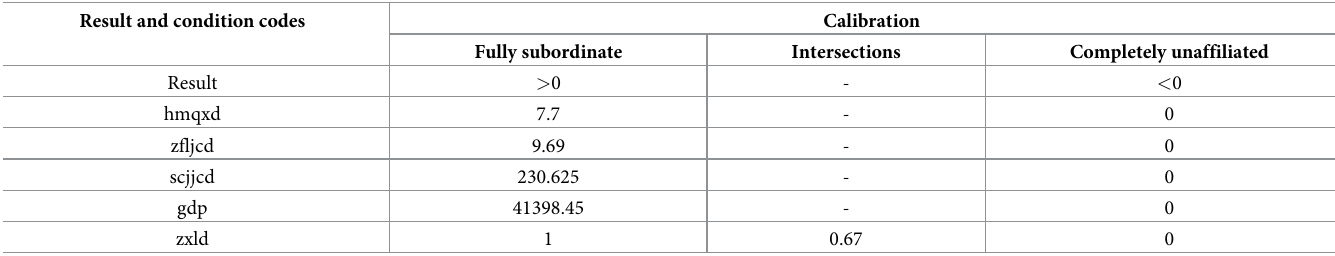
Table 4. Calibration of results and